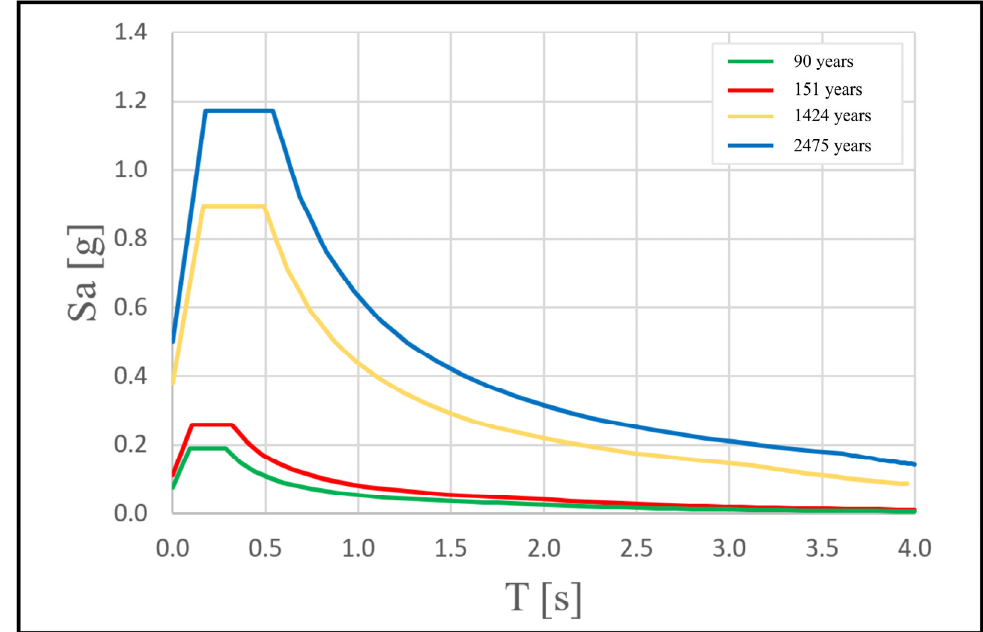
Figure 4. Spectra of the horizontal seismic action provided by Italian building code for different return periods with a nominal life of 100 years and use coefficient 1.5 related with the selected typology of building (e.g., Church).